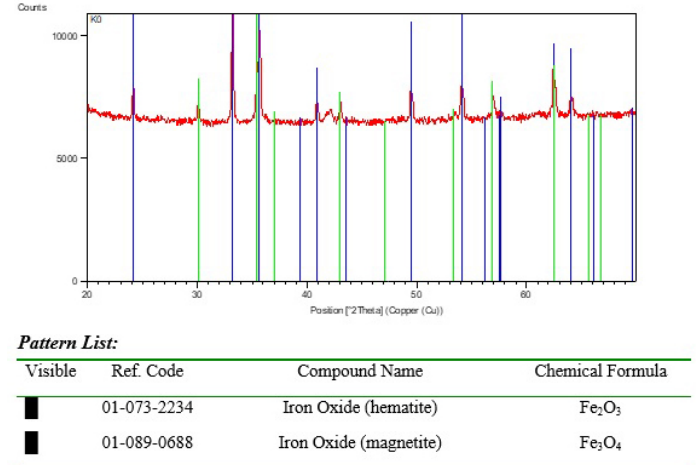
Figure 5. Result of qualitative XRD analysis of the used Hot-Rolled mill scale powder.